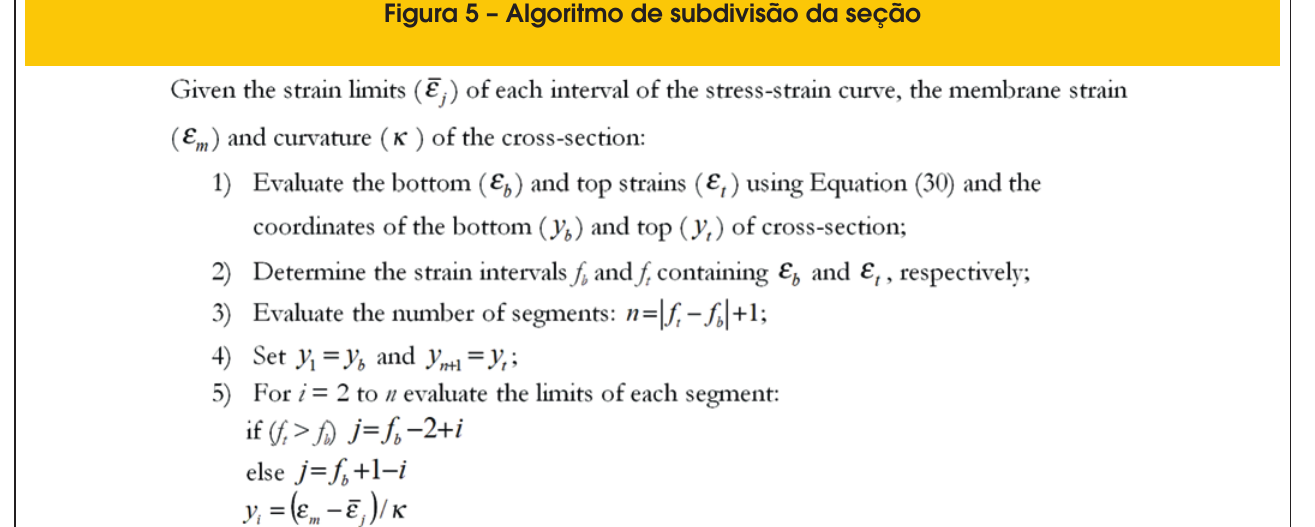
Figura 5 – Algoritmo de subdivisão da